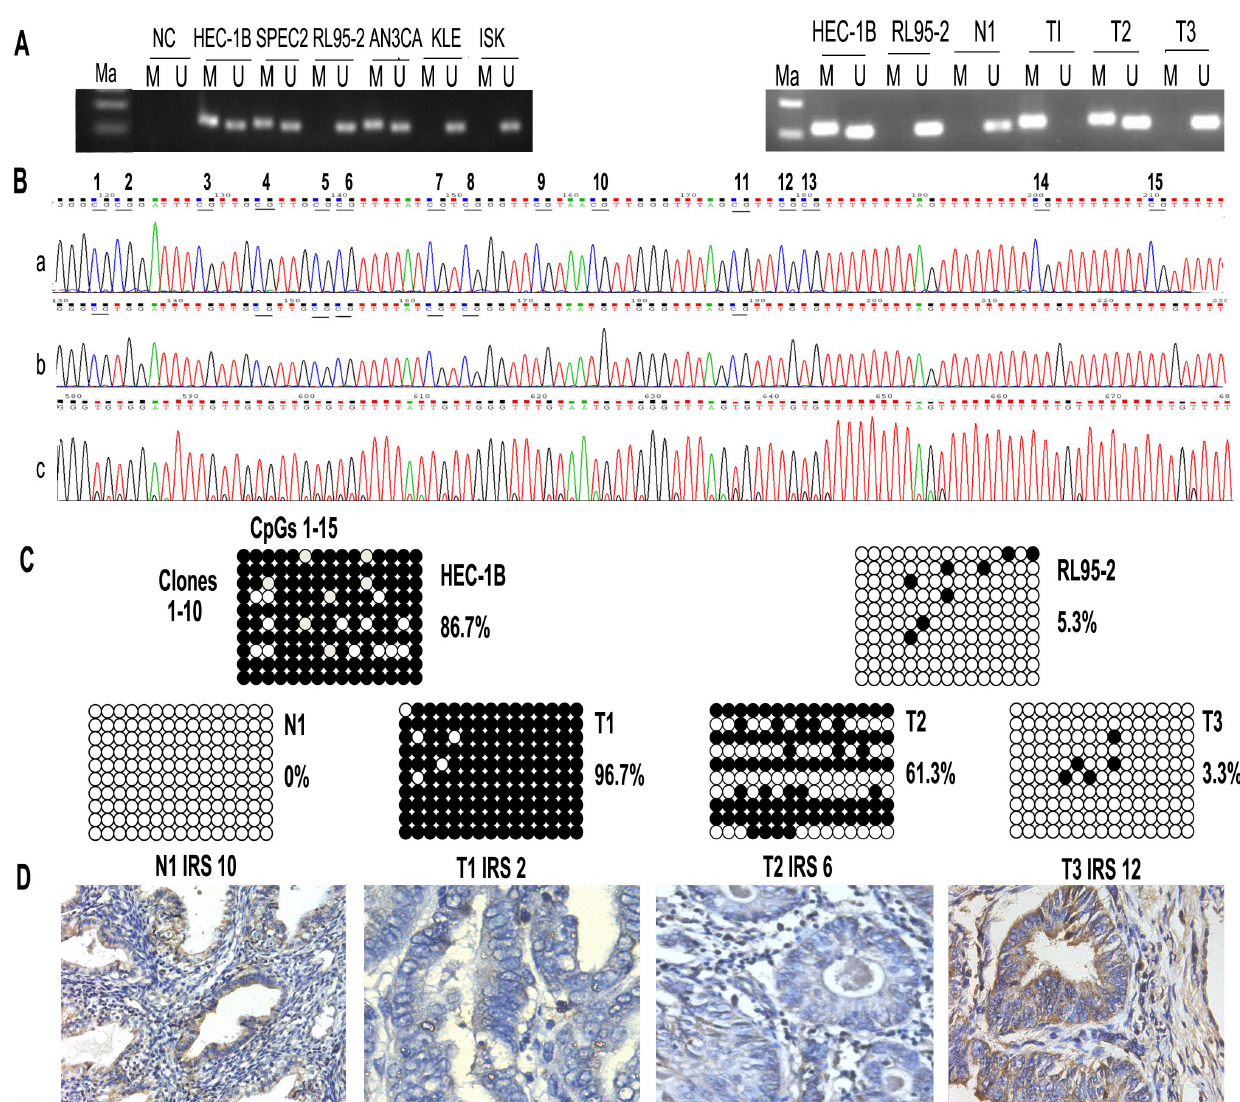
Figure 2. Methylation status of EFEMP1 in cell-lines and tissues. A: MSP was used to determine the methylation status of EFEMP1 in EC cells and tissues, NC=H 2 O; N=normal endometrial tissue; T=endometrial carcinoma; M=PCR products amplified by MSP specific for methylated DNA; U=PCR products amplified by MSP specific for unmethylated DNA. B: Showing three examples of the different methylation sequences as revealed by bisulfite genomic sequencing. (a) Shows a fully methylated sequence with 15 methylated CpGs. The cytosine nucleotides were not converted into thymines. (b)Shows a partly methylated sequence and only CpGs 1, 4, 5, 6, 7, 8 and 11 were methylated. (c) Shows a fully unmethylated sequence since all cytosine nucleotides of the 15 CpGs were converted into thymines. C: Bisulfite genomic sequencing detected endogenous levels of methylation among the endometrial carcinoma cell-lines HEC-1B and RL95-2, normal endometrium (N1) and endometrial carcinoma tissues (T1, T2, T3). Columns indicate CpG dinucleotides 1–15, and horizontal lines analyzed clones 1–10. Black dots symbolize methylated CpGs, and white dots symbolize unmethylated CpGs. D: Showing immunohistochemical staining of tissues with known methylation status as above. Magnification